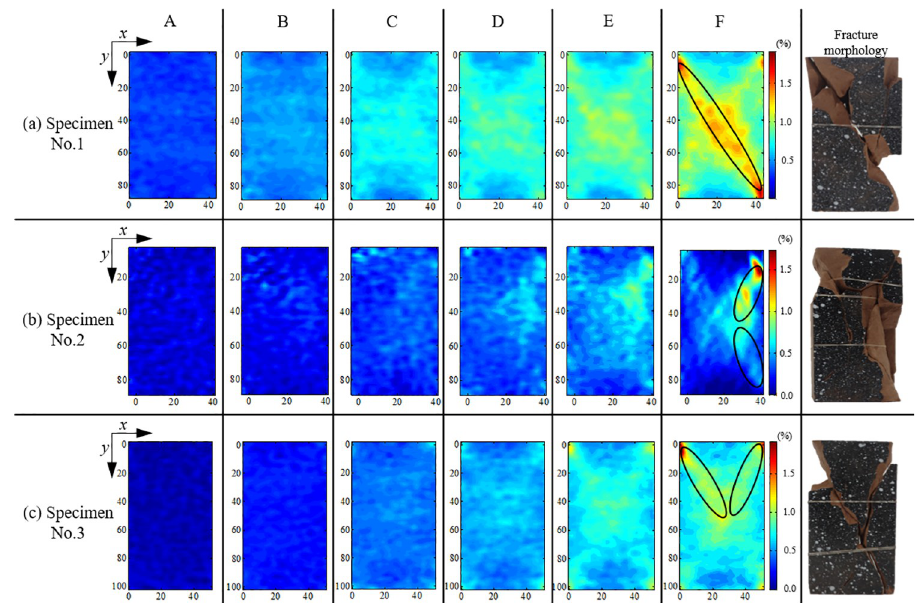
Fig 6. Shear strain-field ( γ xy ) and fracture morphology for (a) Specimen No. 1; (b) Specimen No. 2; (c) Specimen No. 3. than that at the top for all specimens due to application of load from bottom of each specimen. At marker A, the vertical displacement in specimen surface varied slightly without evident change in gradient, specifically in specimens No. 2 and No. 3. At markers B and C, with an increase in load, each part of the specimen developed vertical displacement uniformly with an evident displace- ment gradient. Once the inherent heterogeneous micro-structure (generally considered as the new microcrack) started developing at plastic strain stage (markers D and E), the displacement gradient changed unevenly in the horizontal direction for all three specimens. For instance, the displacement gradient of u at the top and bottom of the specimens at marker F showed concave y and convex trends, respectively. The heterogeneous variation in the displacement-field contrib- uted in expanding and connecting the microcracks; this phenomenon was more evident for γ . xy In Fig 6(A)–6(C), the images are γ contours for markers A, B, C, D, E, F and fracture mor- xy phology from left to right, and the x and y axes represent width and length of the ROI. As shown in Fig 6, the strain value in γ at marker A is relatively small, and larger strain points xy are distributed sporadically (due to low stress and microcrack closure). At initial linear elastic strain stage (marker B), the strain was relatively uniform throughout the entire specimen due to small microcrack initiation in the three specimens. Moreover, γ does not show a clear dif- xy ference between the larger and smaller strain points. However, later at this stage (marker C), a little microcrack was developed, and a gathering zone of the larger strain points was appeared, which could be the latent damage initiation. When the plastic strain occurred, owing to the sufficient microcrack development and rearrangement, the strain localization was appeared, i.e., the regional difference between the larger and smaller strain points formed for the three specimens (refer marker D in Fig 6). After continued loading, the regional difference devel- oped continuously and rapidly (markers E and F in Fig 6), and a single band was observed for specimen No. 1 (refer ellipse at marker F in Fig 6(A)), while two bands developed with an angle for specimens No. 2 and No. 3 (refer ellipse at marker F in Fig 6(B) and 6(C), respectively). Finally, for all three specimens, the strain of the regional difference reached a certain degree where the macroscopic fracture was occurred (refer broken rock specimens in Fig 6). In general,